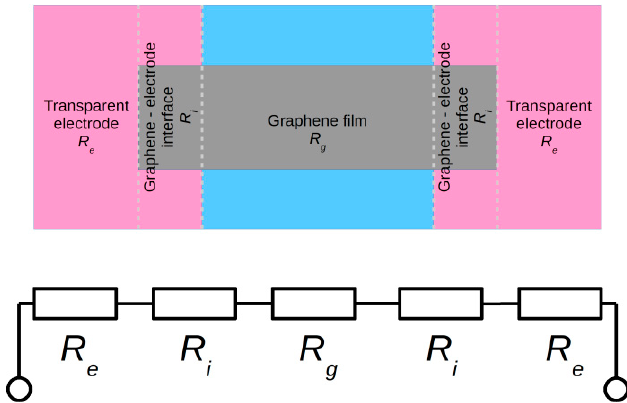
Figure 5. Equivalent circuit of graphene temperature sensor.